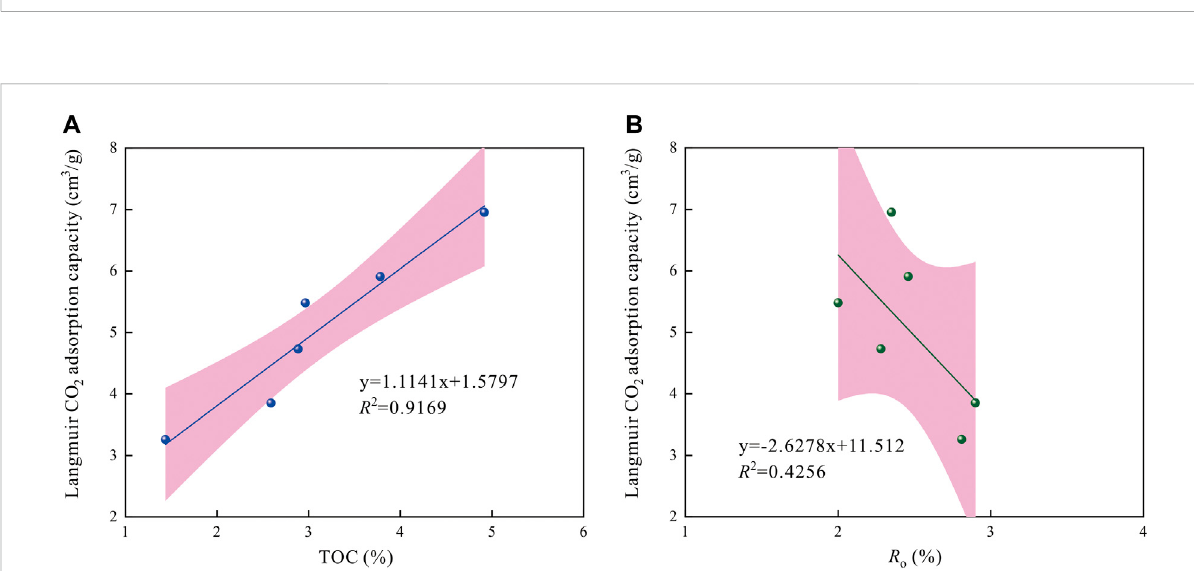
FIGURE 7 The CO 2 isothermal adsorption data with respect to different pressures for the shales.